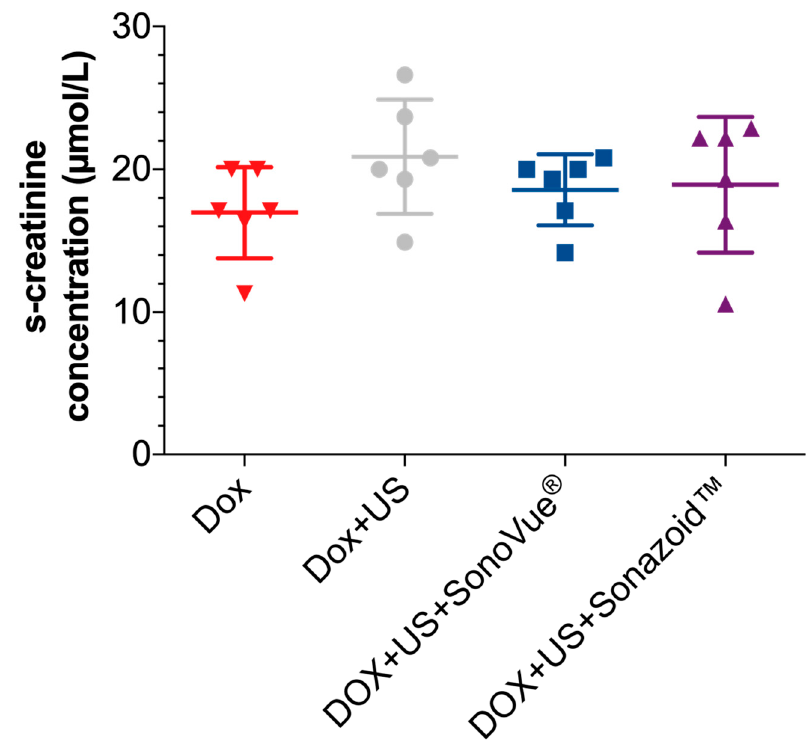
Figure 7. Serum creatinine measurements at day 9 and day 35 combined after treatment. Although higher creatinine concentrations were detected in the treatment groups, they were not significantly higher than in the control group.